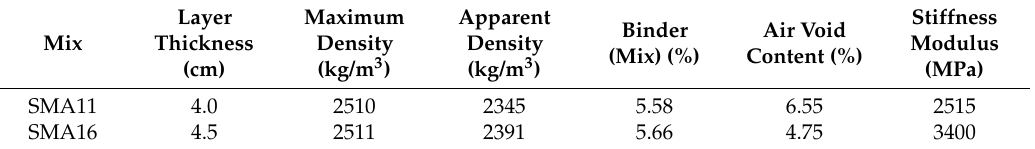
Table 1. Construction characteristics of studied mixtures stone mastic asphalt (SMA).